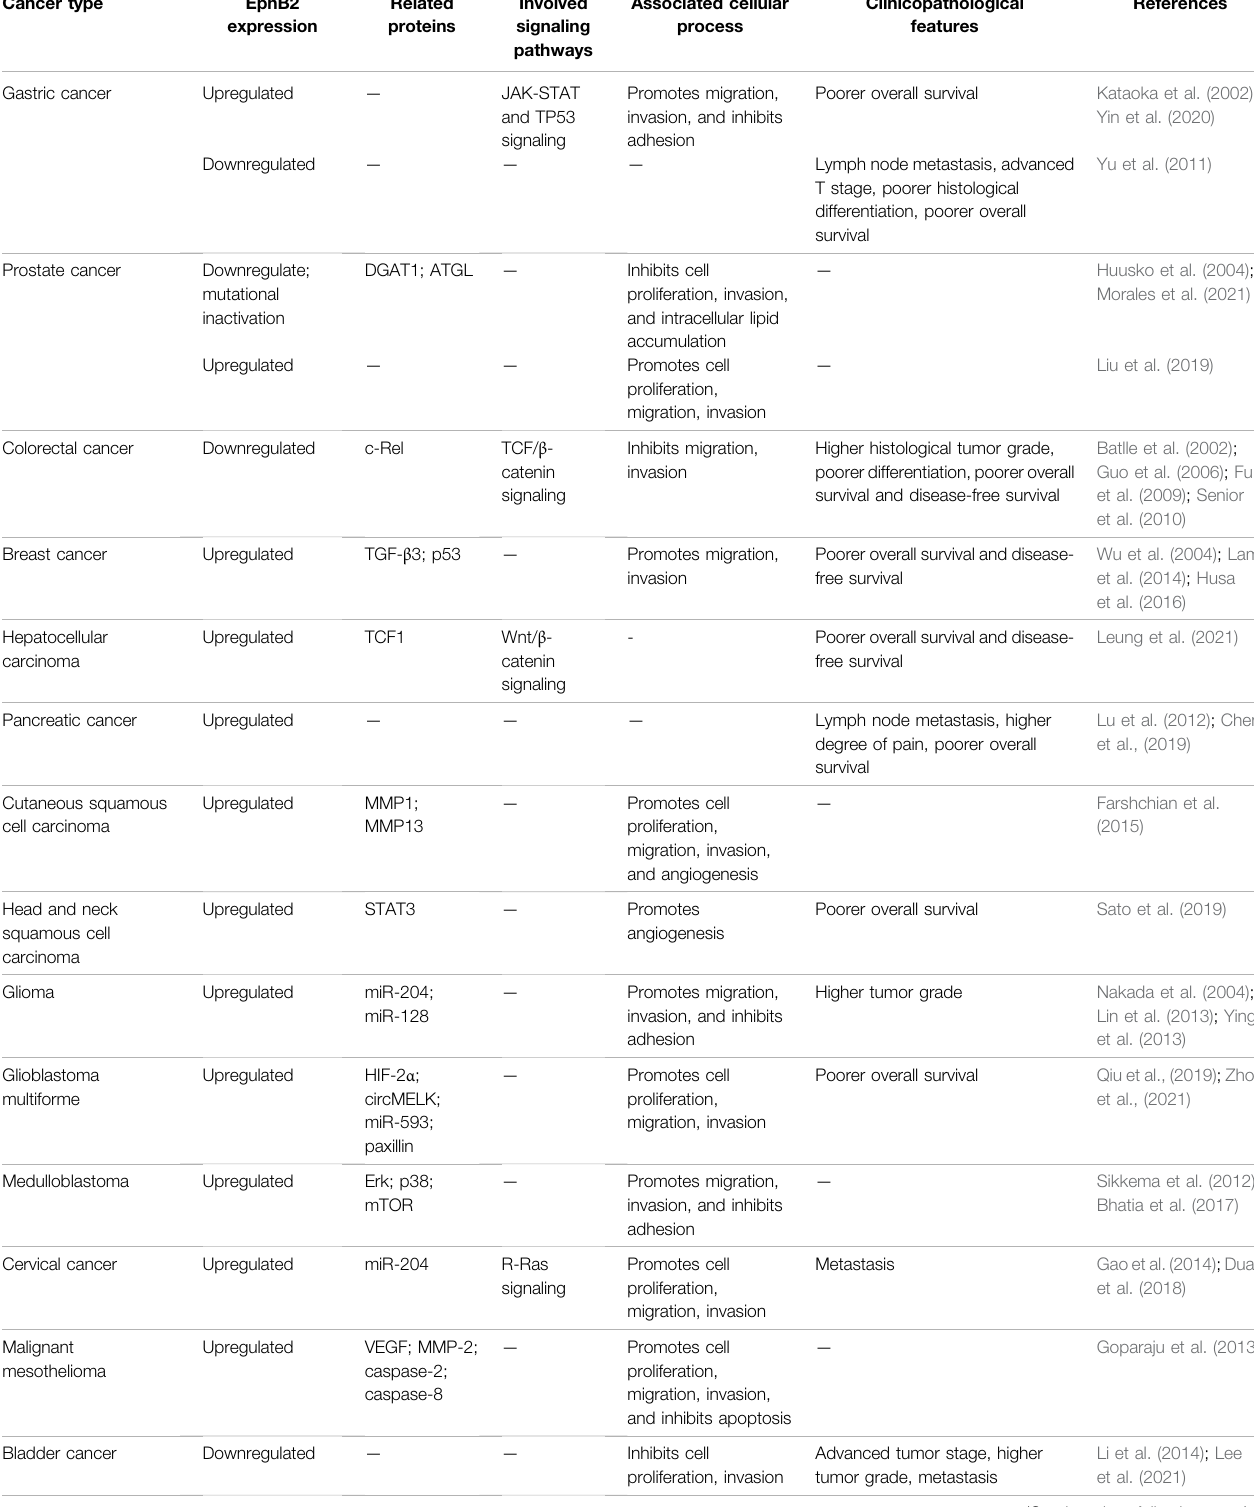
TABLE 1 | The expression levels and functions of EphB2 in different